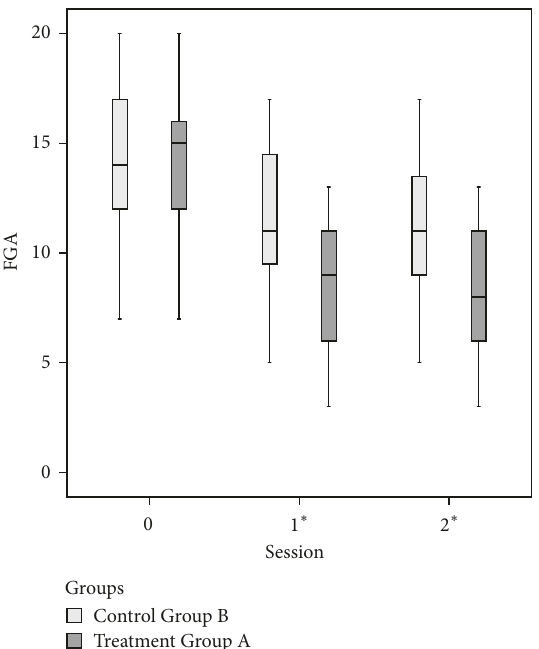
Figure 3: Functional Gait Assessment (FGA) at baseline (= T 0) and at the end of treatment (= T 1) and follow-up (= T 2) for the two groups. The symbol “ ∗ ” indicates 𝑝 < .05 .